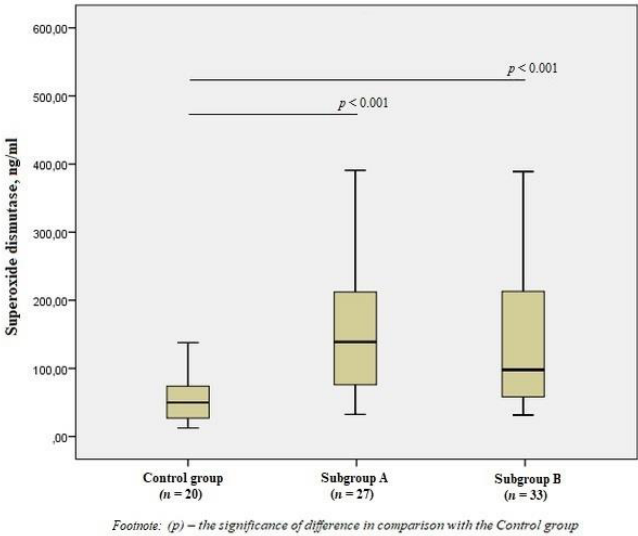
Figure 2. The content of superoxide dismutase in the blood of men without ischemic artery disease (Control group), men with ischemic artery disease and the presence of vulnerable atherosclerotic plaques in the coronary arteries (Subgroup A) and men with ischemic artery disease and the absence of vulnerable atherosclerotic plaques (Subgroup B), Me (25%; 75%). p — the significance of difference in comparison with the Control group.